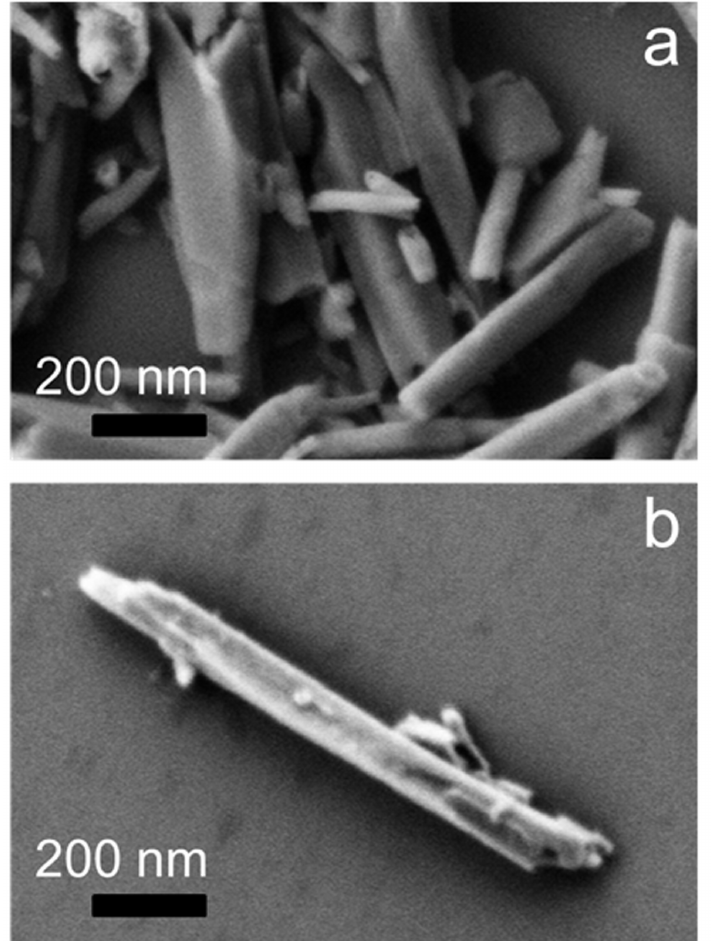
Figure 4. SEM images of pristine HNs ( a ) and DNA–HNs obtained after removal of DNA excess ( b ) deposited on a silicon. Bar is 200 nm. By comparison of pristine and DNA-loaded sample, the irregular appearance of the surface of DNA–HN hybrids due to the DNA layer wrapping the nanotube is immediately